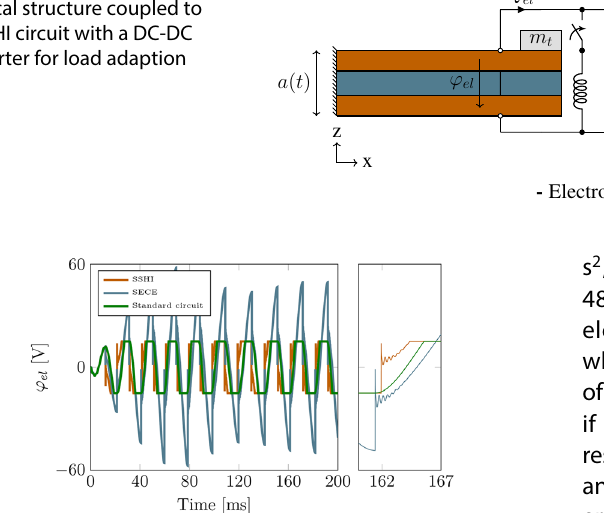
Fig. 14 Bimorph electrome- chanical structure coupled to an SSHI circuit with a DC-DC converter for load adaption